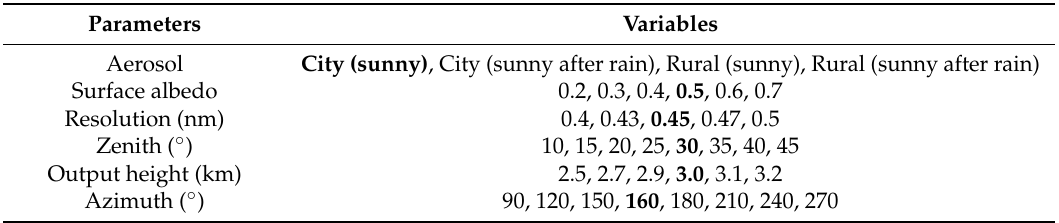
Table 2. Parameters for calculating sensitivity.